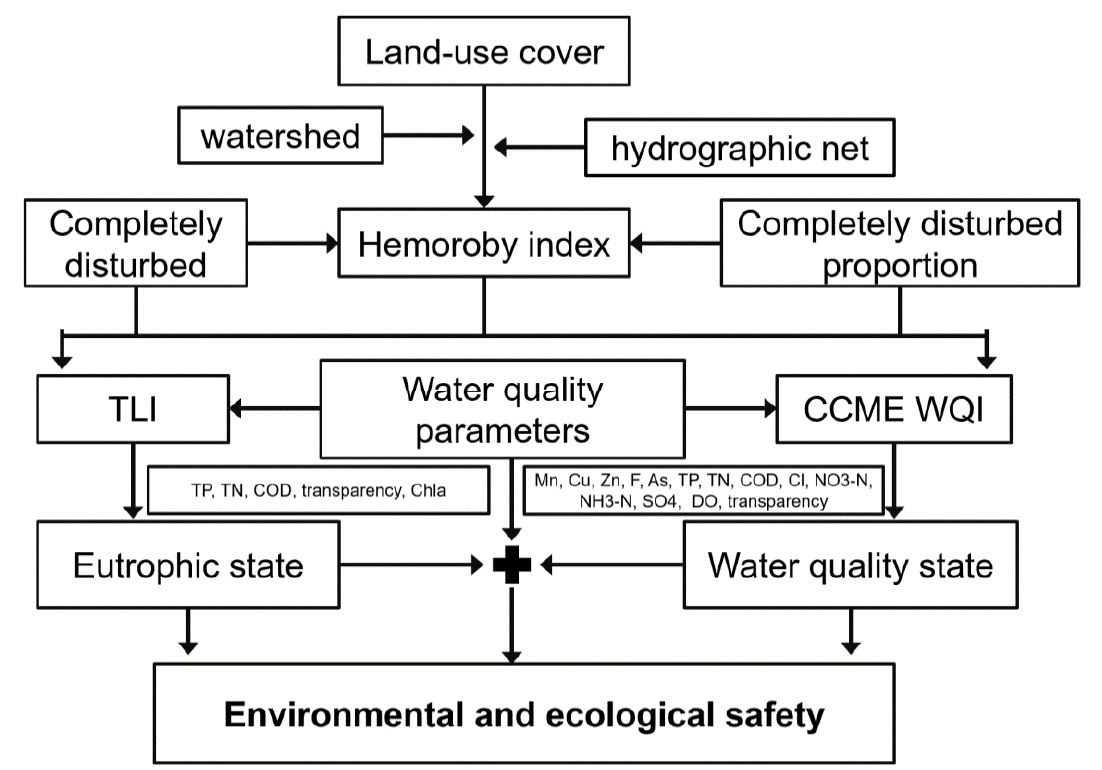
Figure 2. Flowchart of the model construction process for analyzing rivers’ states based on land-use gradient and anthro- pogenic interference.